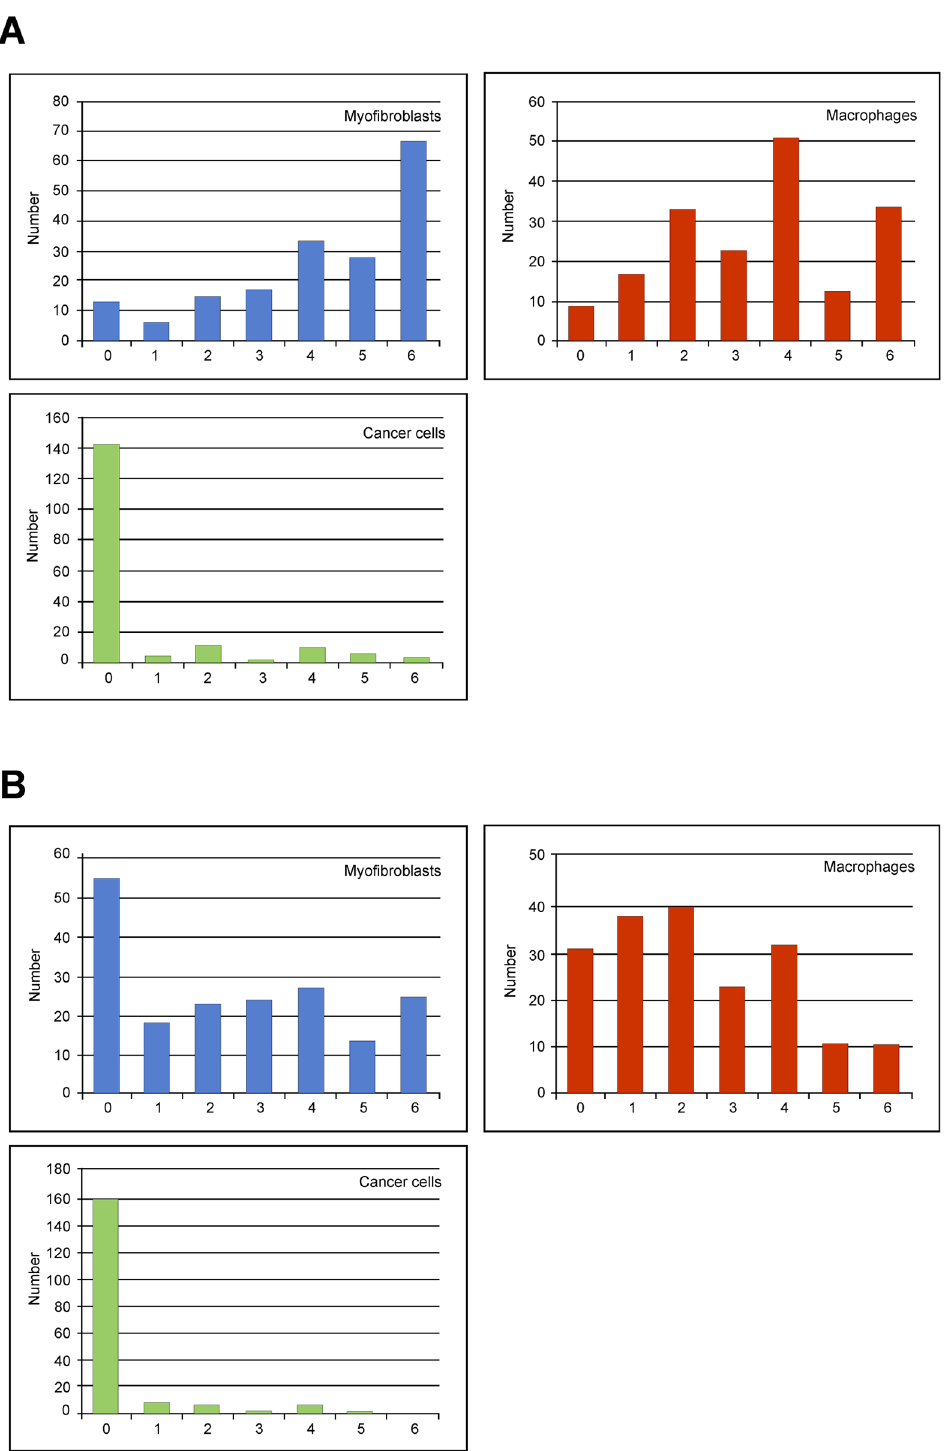
Fig 3. Distribution of the uPAR scores (0 – 6). Myofibroblasts, macrophages and cancer cells located at the invasive front (A) and tumour core (B), respectively. The x-axis shows the assigned uPAR score and the y-axis the patient number.